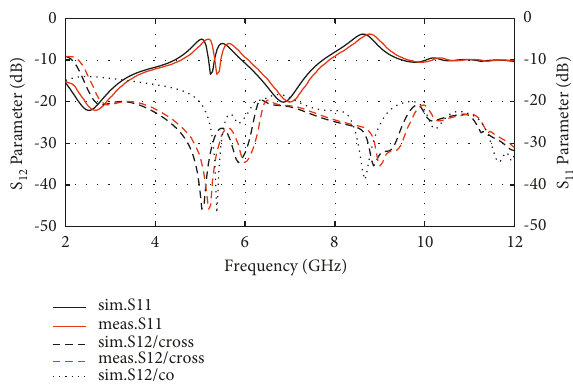
Figure 4: Triple band notches at different frequency against s parameter and co and cross s